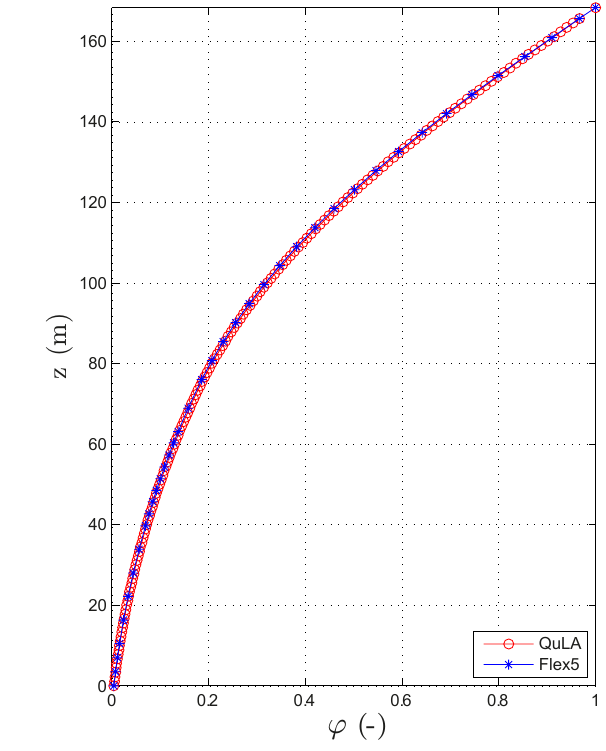
Figure 3. The shape function.